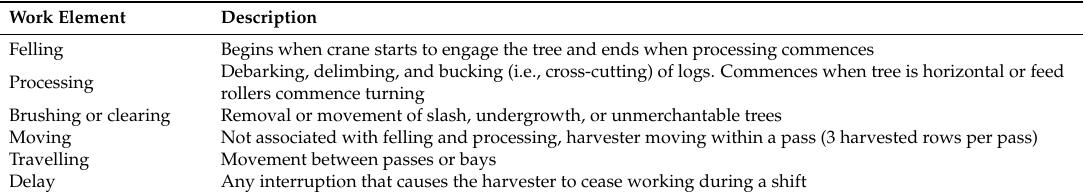
Table 1. Harvesting work elements recorded during the